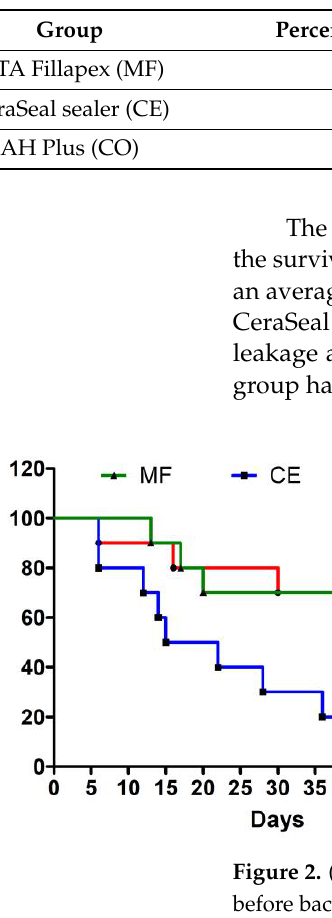
Table 1. The results of bacterial leakage over a period of 60 days and the average duration (days) until bacterial leakage.